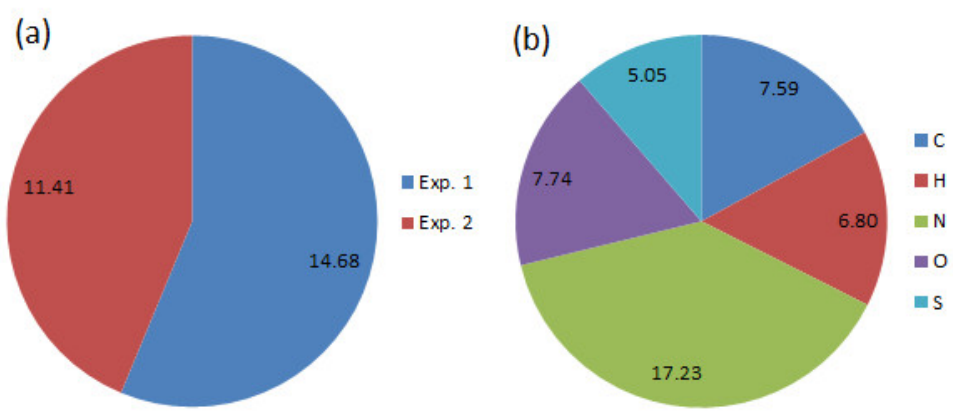
Figure 18. ( a ) Percentage of losses in the experiments; ( b ) average percentage of atom losses.